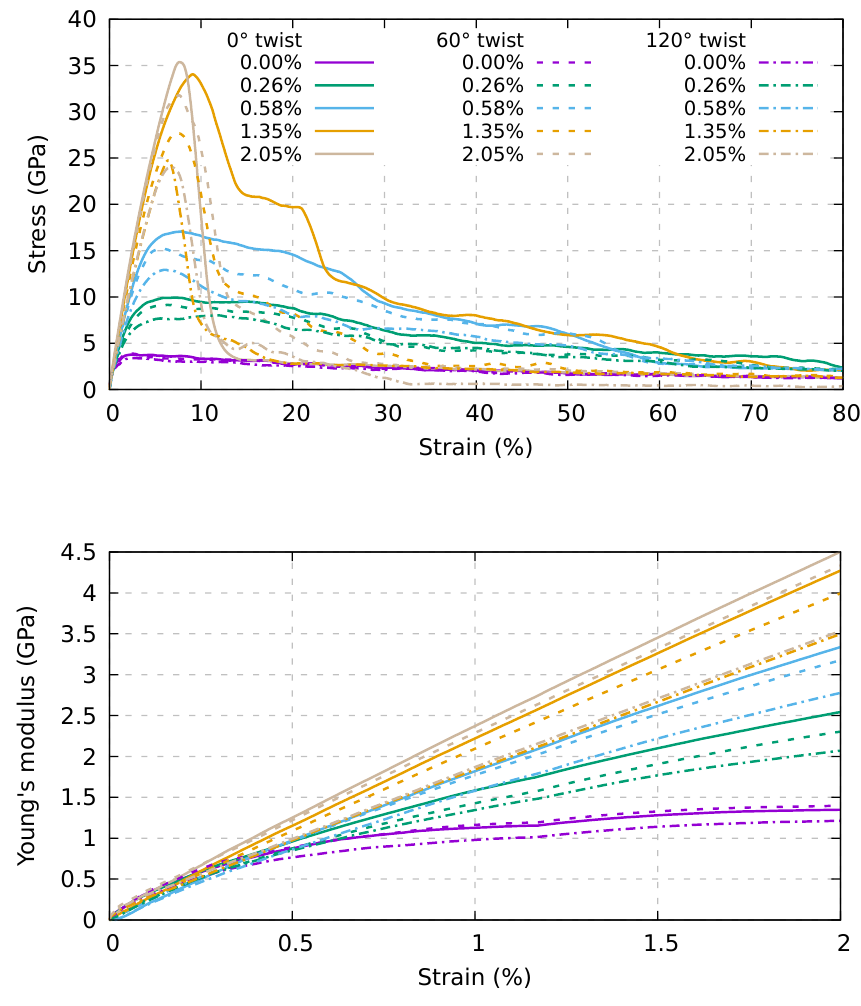
Figure 6. Dependence on twisting and percentage of linkers of the stress–strain response of the bundle composed of 20 nm ( 6,6 ) CNTs ( top ). In the bottom panel, a zoom of the low-strain part of the stress–strain curves reported in the top panel is shown. AIREBO-mod potential and a strain velocity of 1.0 Å/ps were